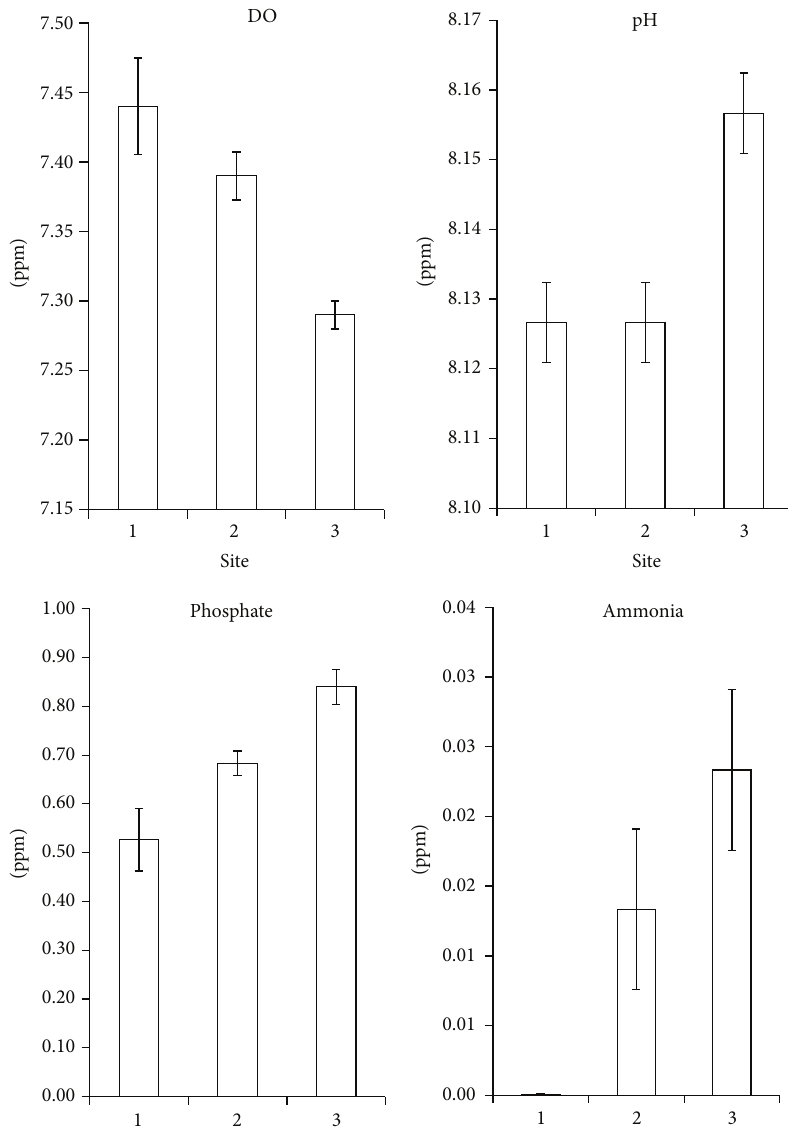
Figure 2: Average values of DO, pH, phosphate, and ammonia concentration in sampling sites (mean ± SD, with 𝑛 = 6 ).